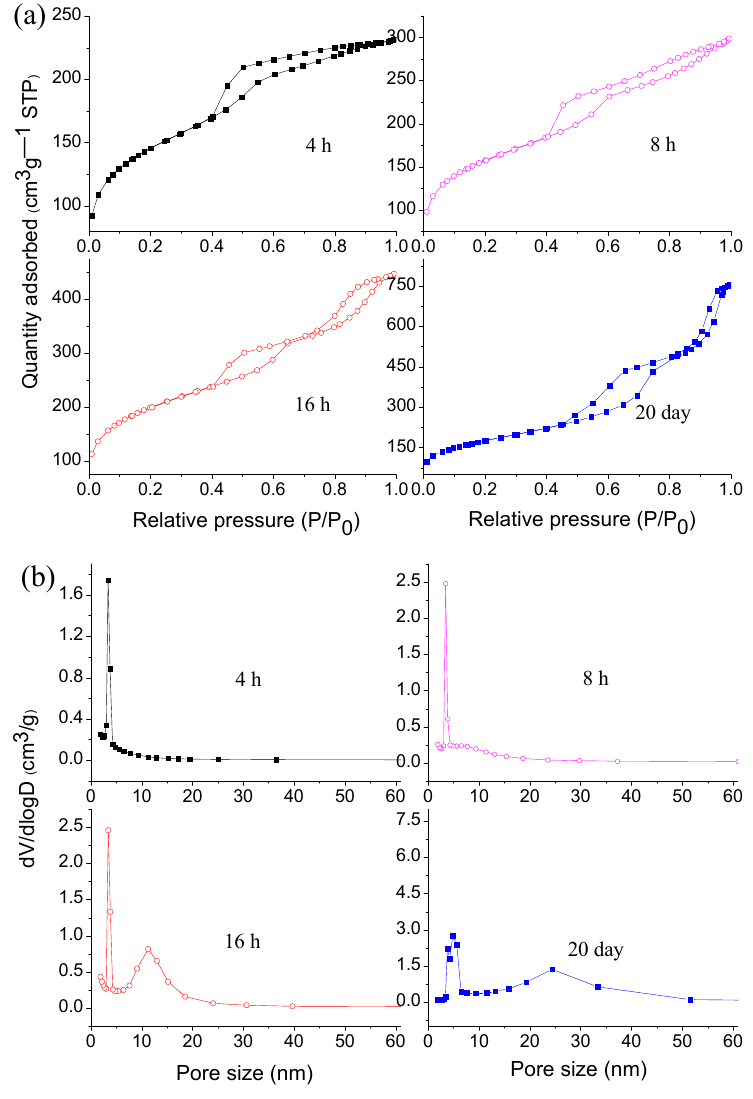
Figure 3. The curves of N 2 -BET ( a ) and pore size distribution ( b ) for HMS samples were selected as the function of reaction time ranges from 4 h to 480